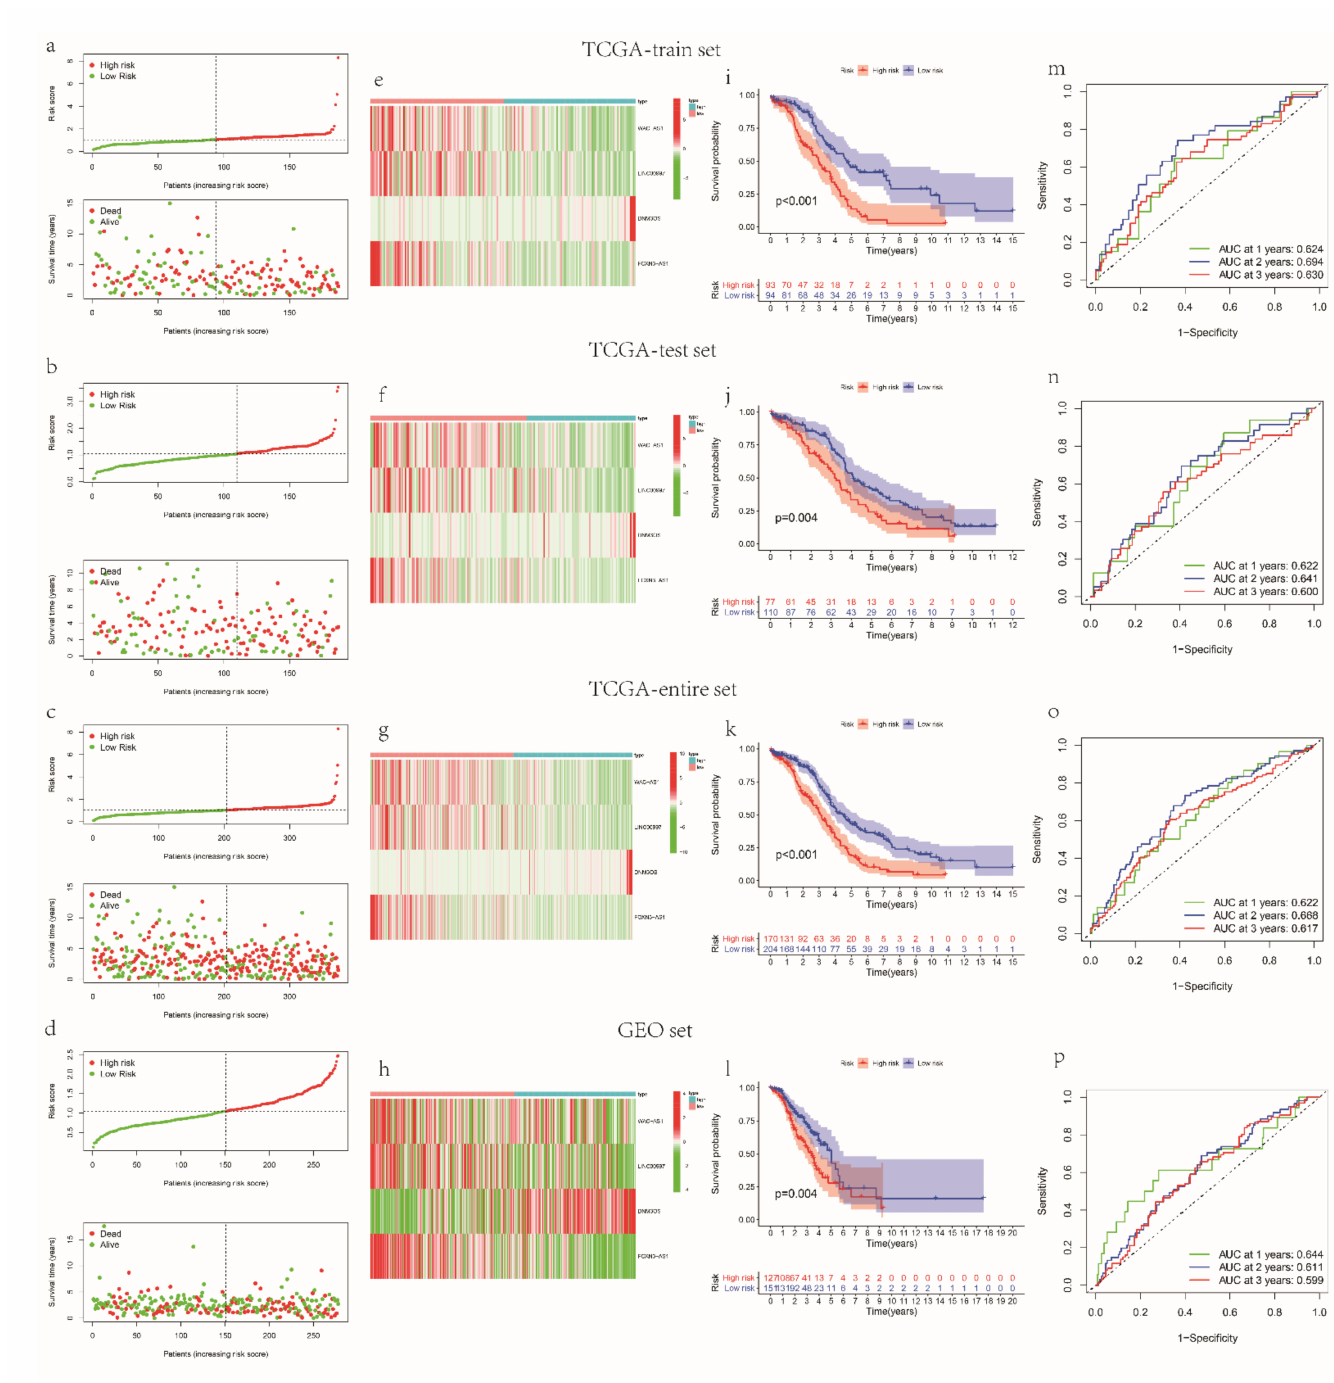
Figure 2. Construction and validation of the mRL prognostic signature. Distribution of risk score, OS status ( a – d ) and heatmap of the expression of the four prognostic mRLs ( e – h ) in the TCGA-train, test, entire and GEO dataset. ( i – l ) Kaplan–Meier curves of OS for OV patients with a high- or low- risk score in the TCGA-train, test, entire and GEO dataset. ( m – p ) Time-dependent ROC analysis of risk score in predicting the prognosis in the TCGA-train, test, entire and GEO dataset. ROC, receiver-operating characteristic. In the TCGA-train set, N = 187; in the TCGA-test set, N = 187; in the TCGA-entire set, N = 374; in the GEO set, N =